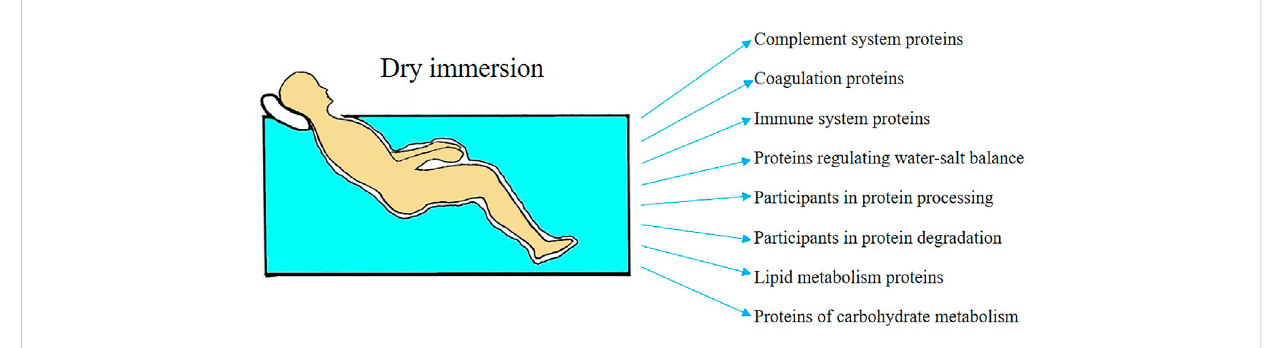
In fl uence of dry immersion factors on proteins involved in various biological